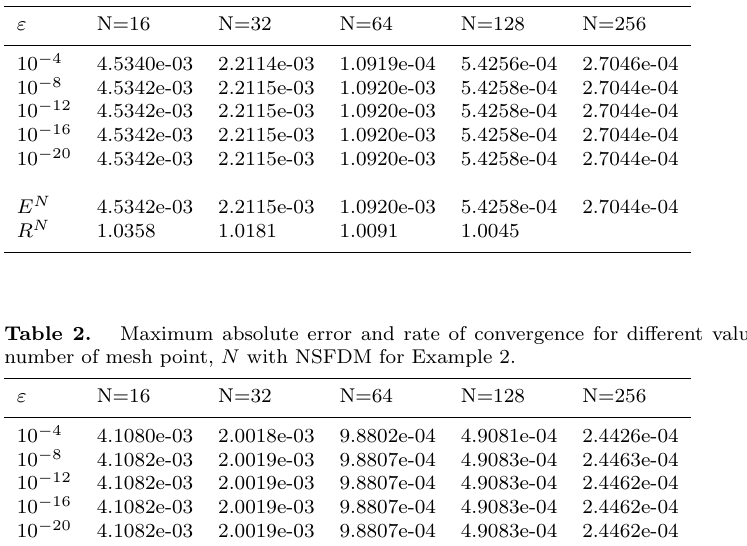
Table 1. Maximum absolute error and rate of convergence for different values of ε and number of mesh points, N with nonstandard FDM for Example 1.